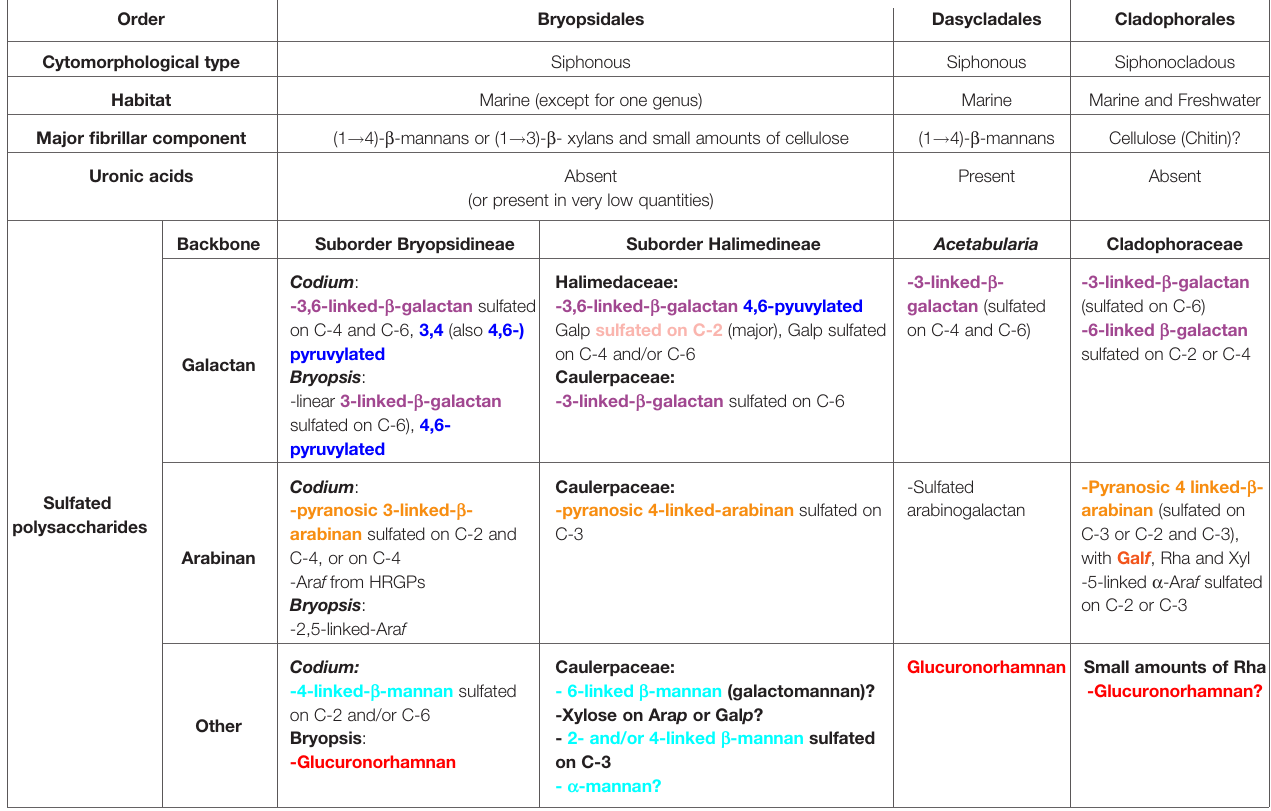
TABLE 1 | General characteristics of cell wall polysaccharides from coenocytic green